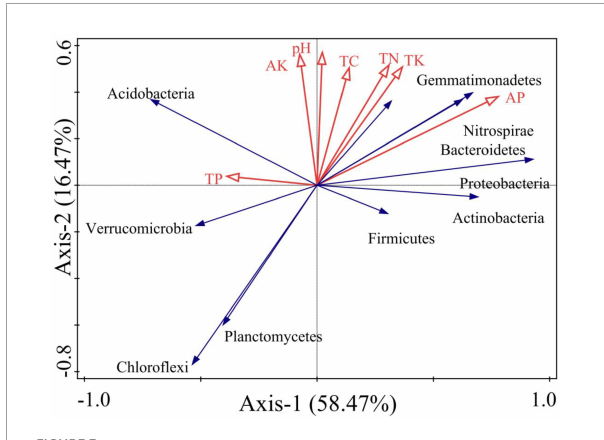
FIGURE3 Redundancy analysis of bacterial community structure and soil chemical properties. The TP, TC, TN, TK, AK, and AP stand for total P, total C, total N, total K, available K and available P, respectively.